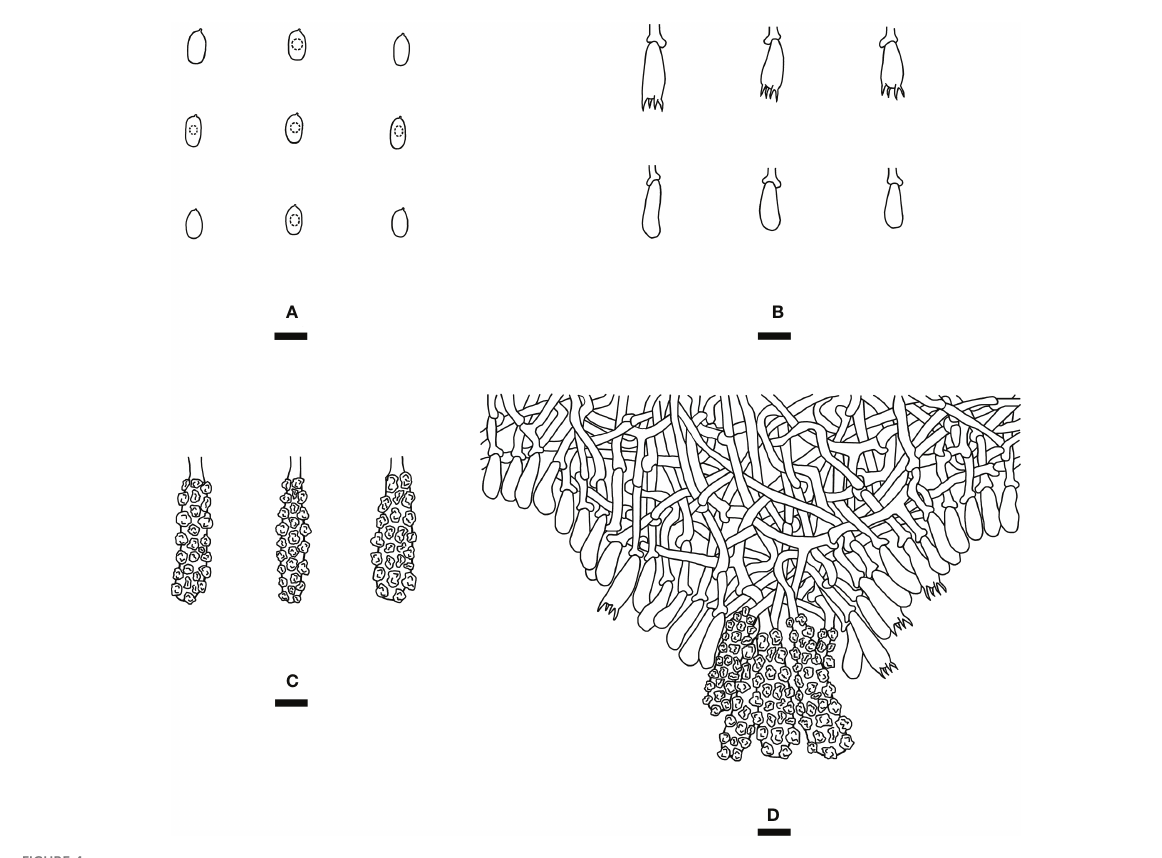
FIGURE 4 Microscopic structures of Steccherinum fi ssurutum (drawn from the holotype). (A) Basidiospores. (B) Basidia and basidioles. (C) Skeletocystidia. (D) A section of hymenium. Bars: (A) 5 µm; (B – D) 10